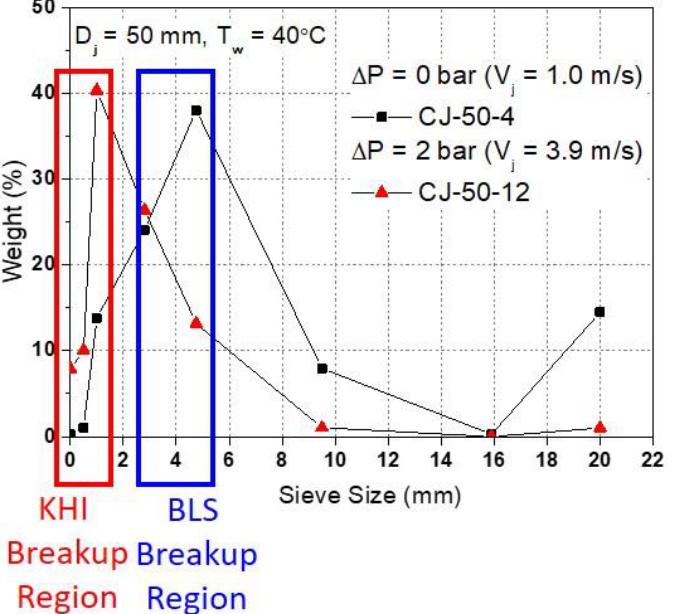
Figure 17. Identification of breakup modes on the particle size distribution of COLDJET experiment [13]: red box indicates particle sizes obtained from KHI simulation, and blue box indicates particle sizes obtained from BLS simulation.